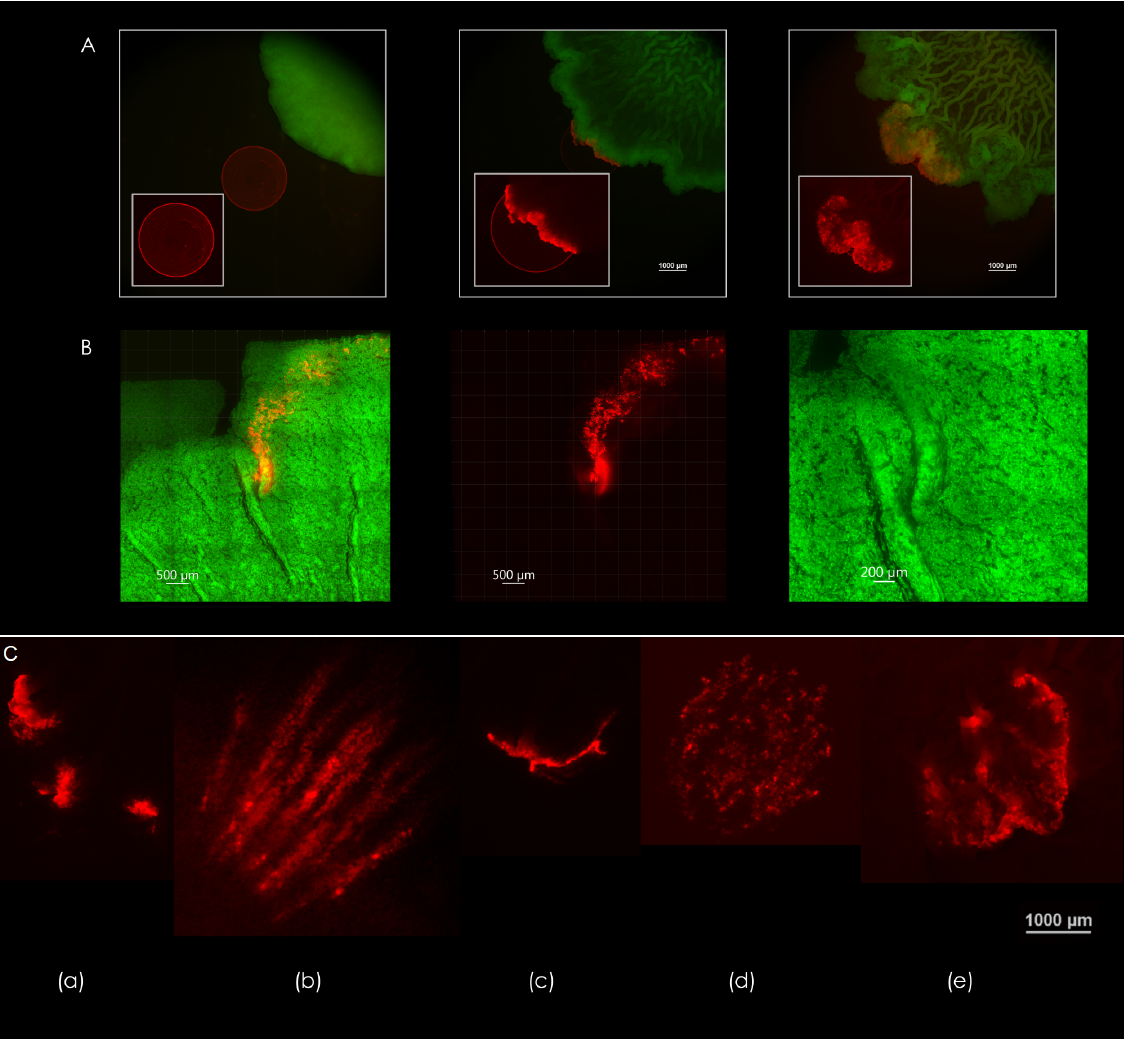
Figure 4. Expansion patterns at the biofilm-agar interface. ( A ) Forces generated by the biofilm as reflected in the deformation of a droplet consisting of fluorescent microspheres (2.5 µL). Days 1-3 are shown, left to right. Scale bars 1000 µ m. ( B ) Pathway of microspheres in a droplet caught in a channel formed by a 50% nutrient-depleted macrocolony. Scale bars 500 µ m. Rightmost image is a close up of the formed channels—scale bar 200 µ m. ( C ) Different modes of deformation found at the contact surface—( a ) segmented, ( b ) filamentous, ( c ) unidirectional, ( d ) multidirectional, ( e ) turbulent. The images in ( A , C ) are representative of eight experiments. Scale bar 1000 µ